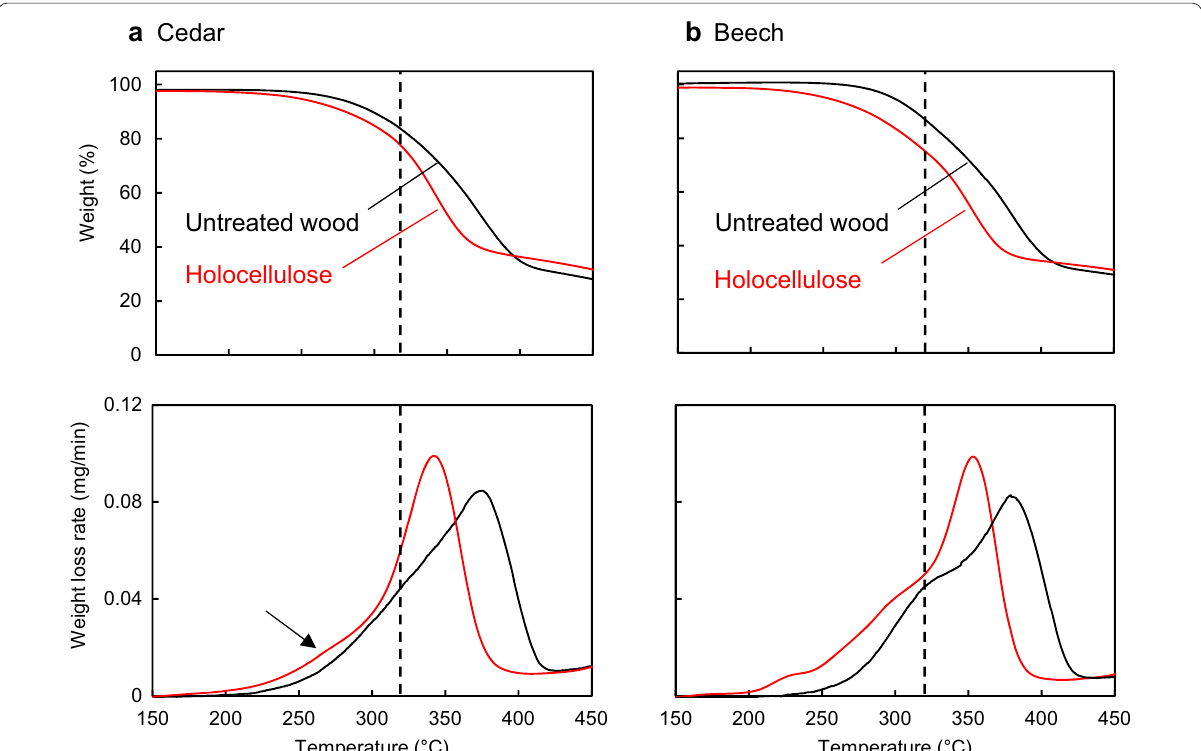
Fig. 2 TG/DTG curves of Japanese cedar and Japanese beech wood: untreated and after delignification. Dashed lines at 320 °C are inserted to facilitate